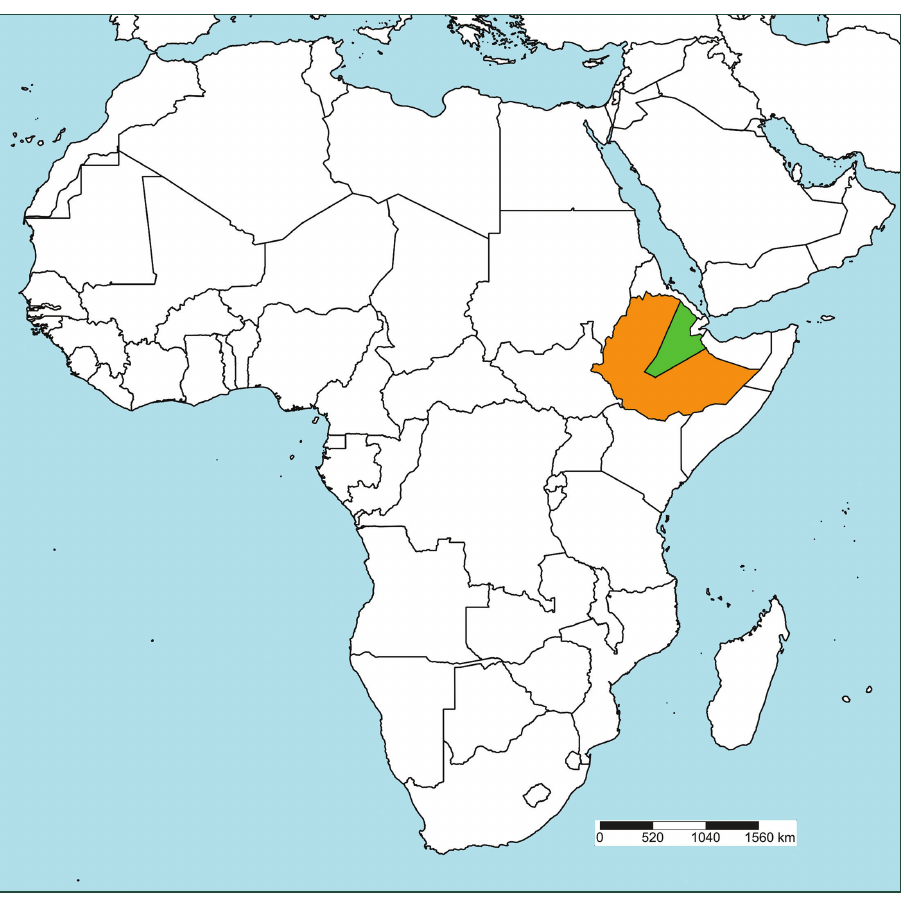
Figure 1. Map of Africa with Ethiopia (orange) including the Awash River catchment